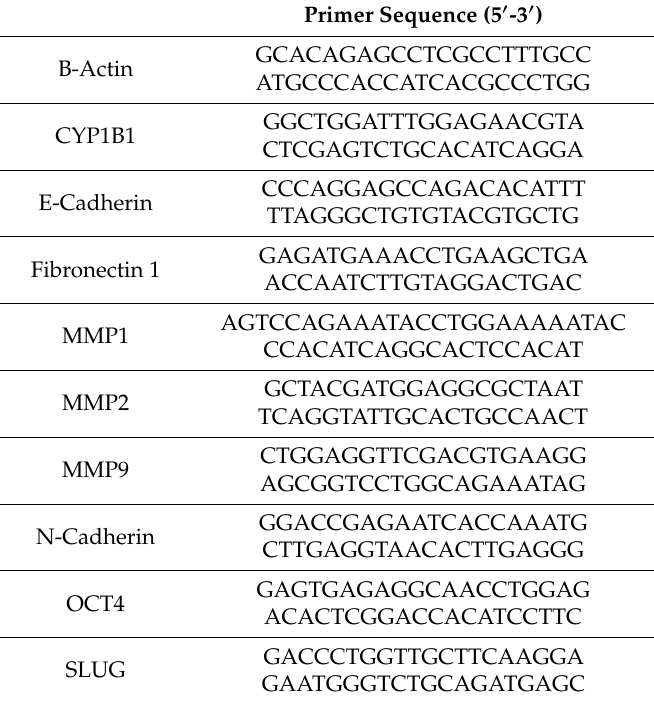
Table 3. Primers used for the real-time quantitative PCRs. The sense primer is listed first and the antisense primer